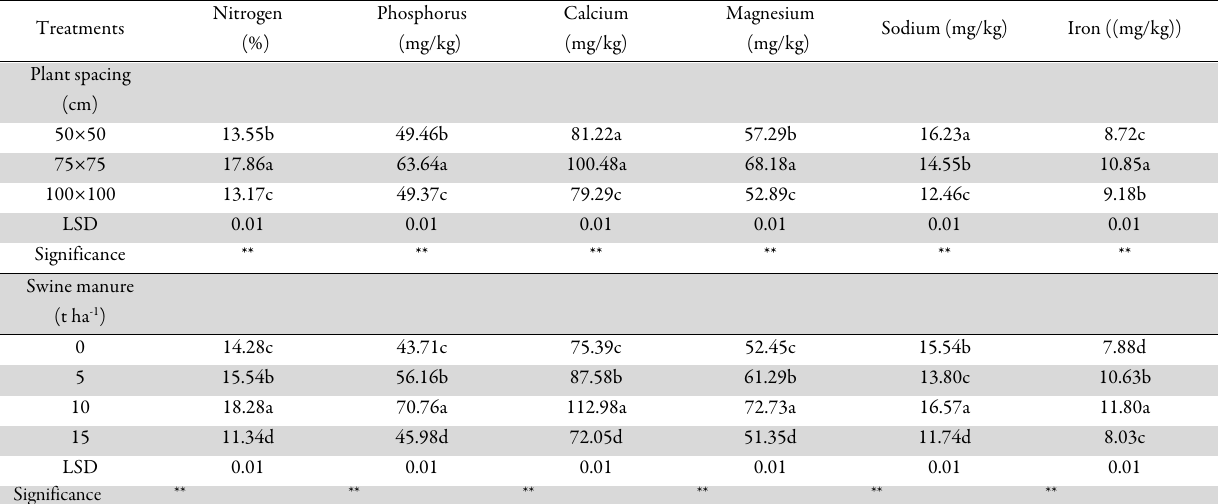
Table 6. Effects of spacing and levels of swine manure application on yield and nutrient uptake of muskmelon